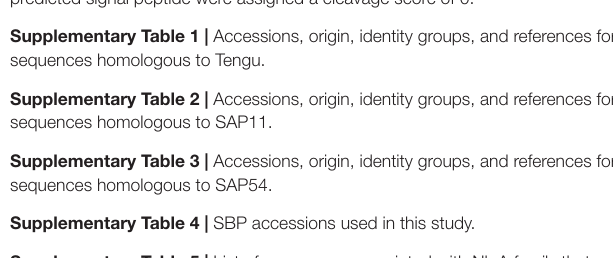
Supplementary Figure 7 | Sequence alignment for the YneF family. The residues have been colored according to biochemical properties up to position 50 of the alignment, and the remaining of the alignment is colored according to conservation between sequences with violet shades. Supplementary Figure 8 | Sequence alignment of the AYWB_444 family. The residues have been colored according to biochemical properties up to position 50 of the alignment, and the remaining of the alignment is colored according to conservation between sequences with violet shades. Supplementary Figure 9 | Sequence alignment for the RNAseY family. The residues have been colored according to biochemical properties up to position 65 of the alignment, and the remaining of the alignment is colored according to conservation between sequences with violet shades. In this alignment, only sequences collected from the nr database of NCBI at the date of the study are shown (accessions listed in Supplementary Material SM15). This includes some of the alternative start codons variants (for example accessions AOF54820.1 and WP_069028241.1 that derive from the same gene of maize bushy stunt phytoplasma strain M3), but not the alternative start codons variants mentioned in Supplementary Material 16. Supplementary Figure 10 | Distribution of signal peptide length for the Tengu, SAP11, SAP54, SBP, AYWB_387, AYWB_376, AYWB_042 and Amp datasets. Redundancy between sequences was addressed by counting only unique signal peptides predicted by each software package. Supplementary Figure 11 | Distribution of prediction scores for all the datasets described in this study. In these plots, each sequence in a given dataset is represented by a dot. Orange dots were assigned to sequences with a positive signal peptide prediction. Sequences that were predicted to have no signal peptide are represented by blue dots. Supplementary Figure 12 | Distribution of cleavage scores for all the datasets described in this study. In these plots, each sequence in a given dataset is represented by a dot. Orange dots were assigned to sequences with a positive signal peptide prediction. Sequences that were predicted to have no signal peptide are represented by blue dots. For SignalP5, sequences that had no predicted signal peptide were assigned a cleavage score of 0. Supplementary Table 1 | Accessions, origin, identity groups, and references for sequences homologous to Tengu. Supplementary Table 2 | Accessions, origin, identity groups, and references for sequences homologous to SAP11. Supplementary Table 3 | Accessions, origin, identity groups, and references for sequences homologous to SAP54. Supplementary Table 4 | SBP accessions used in this